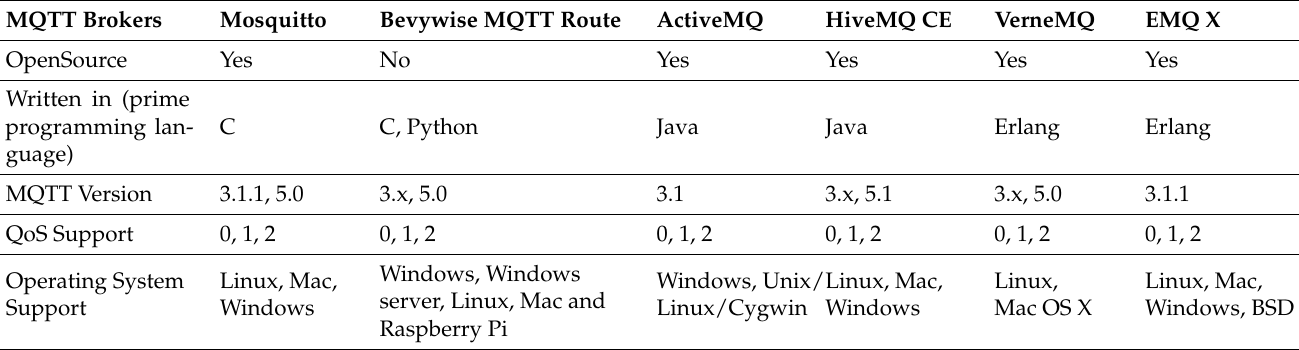
Table 4. A bird’s-eye view of the tested